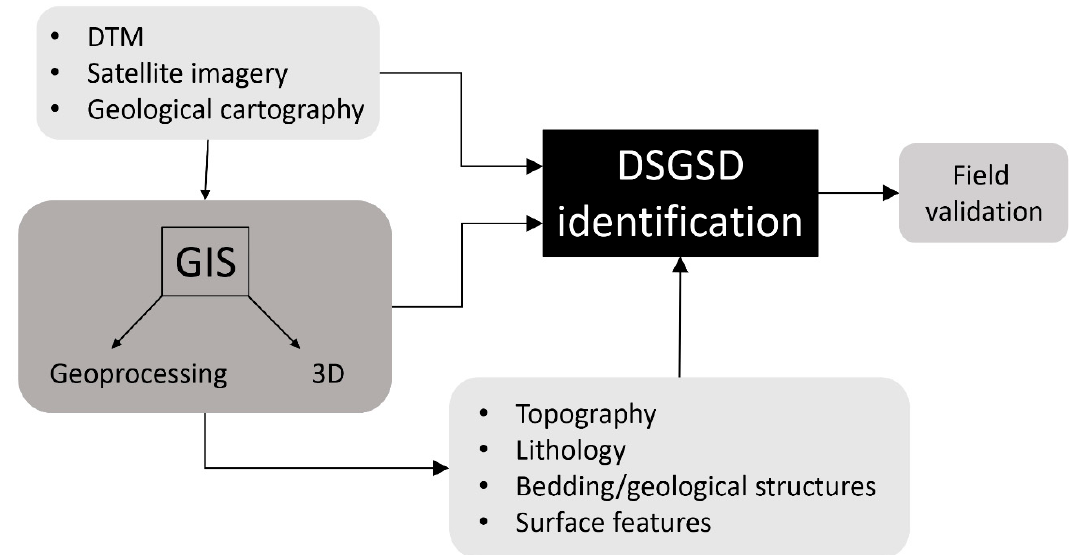
Figure 2. Workflow of the methodology used in the investigation of deep-seated gravitational slope deformations (DSGSDs) in this study.